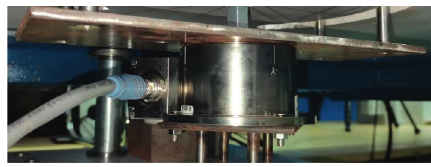
Figure 4: Connection method of force balance.